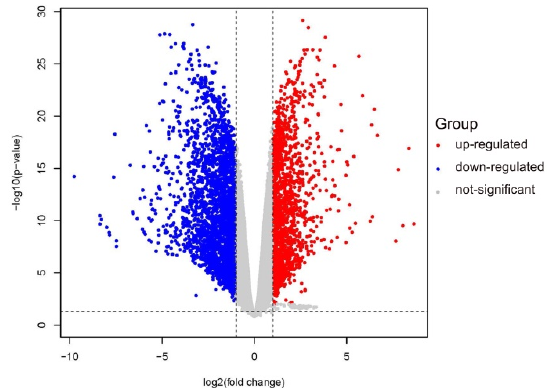
Volcano plot of di ff erentially expressed genes (DEGs) showed up-regulated and down-regulated between control and COS under − 4 ◦ C treatment. The red dots represent up-regulated genes, the blue dots represent down-regulated genes, and the gray dots represent no significant difference. The horizontal coordinates indicate the change in multiple expression, the longitudinal coordinates indicate the magnitude of differences.